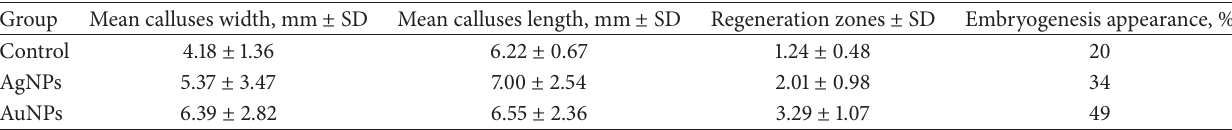
Table 2: Results of morphological parameters of calluses of control and experimental groups ( 𝑛 = 35 ). Means ± SD and significant difference at 𝑃 < 0.05 were indicated, respectively, from the